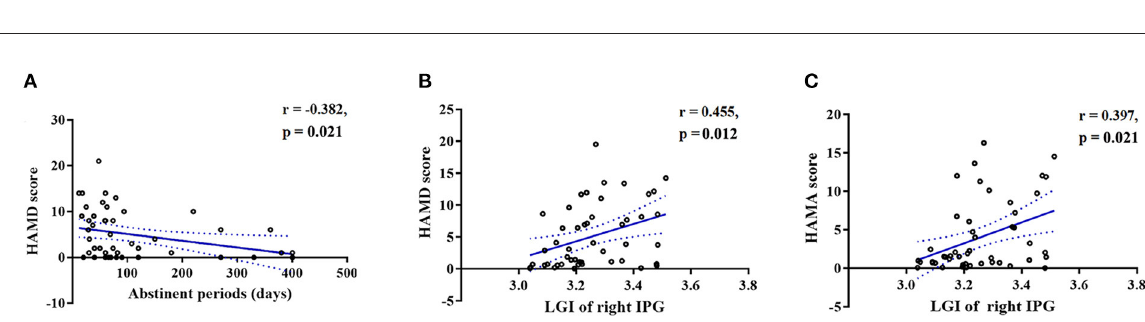
FIGURE3 Scatterplots showing that the duration of abstinence was significantly negatively correlated with (A) HAMD scores in the MUDs. Scatterplots showing that the LGI in the right IPG was significantly positively correlated with the (B) HAMD and (C) HAMA scores in the MUDs. All of the abovementioned correlations, with the exception of those between the duration of abstinence and HAMA scores, remained significant after FDR correction. MUD, methamphetamine use disorder; HAMD, Hamilton depression scale; HAMA, Hamilton anxiety scale; LGI, local gyrification index; IPG, inferior parietal gyrus; FDR, false discovery